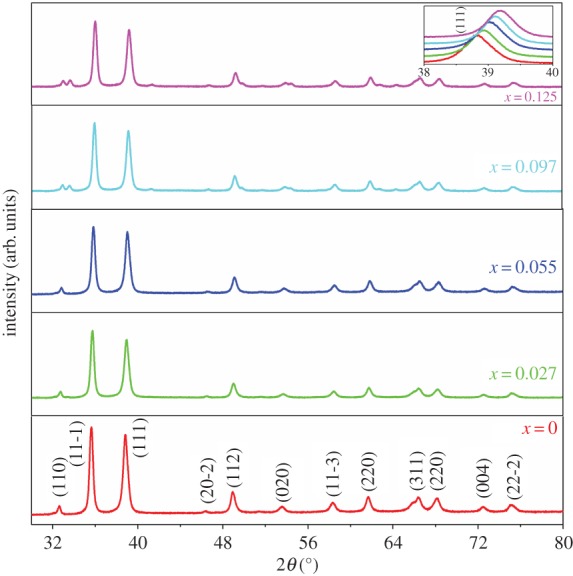
XRD pattern of Cu1-xFexO (0 < x < 0.125) samples revealing a systematic shift in (111) peak towards larger angles.